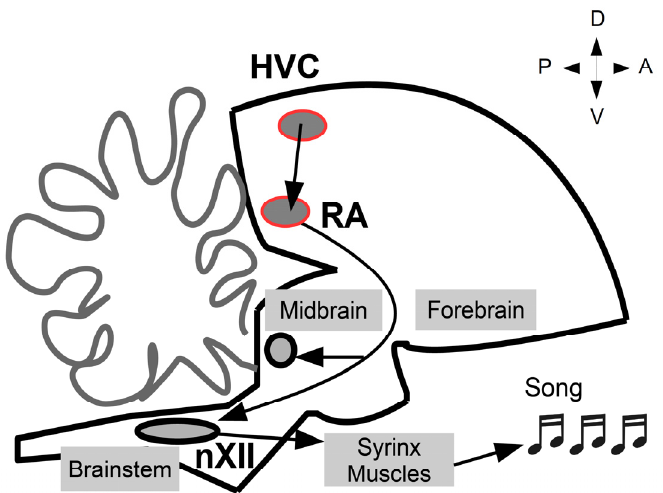
Figure 1. Song system motor pathway. The motor pathway controlling song production starts in the sensorimotor nucleus HVC (proper name). HVC synapses onto premotor nucleus RA (the robust nucleus of the arcopallium), the latter projecting onto brainstem motor nucleus nXII, which drives the contraction of the muscles of the vocal organ, the syrinx, producing songs. A, anterior; P, posterior; D, dorsal; V,